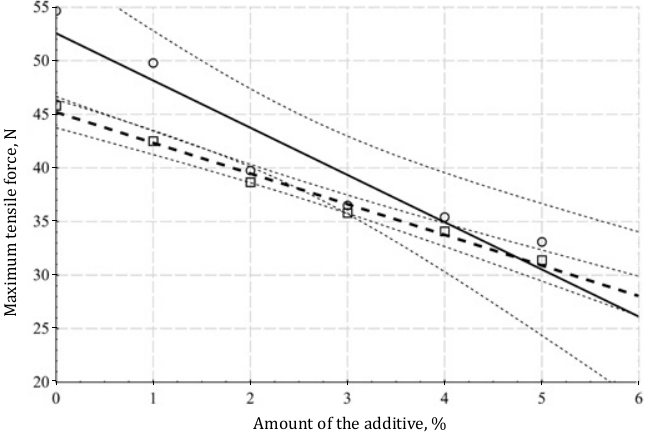
Amount of the additive, Figure 9. The maximum tensile force in the force ductility method